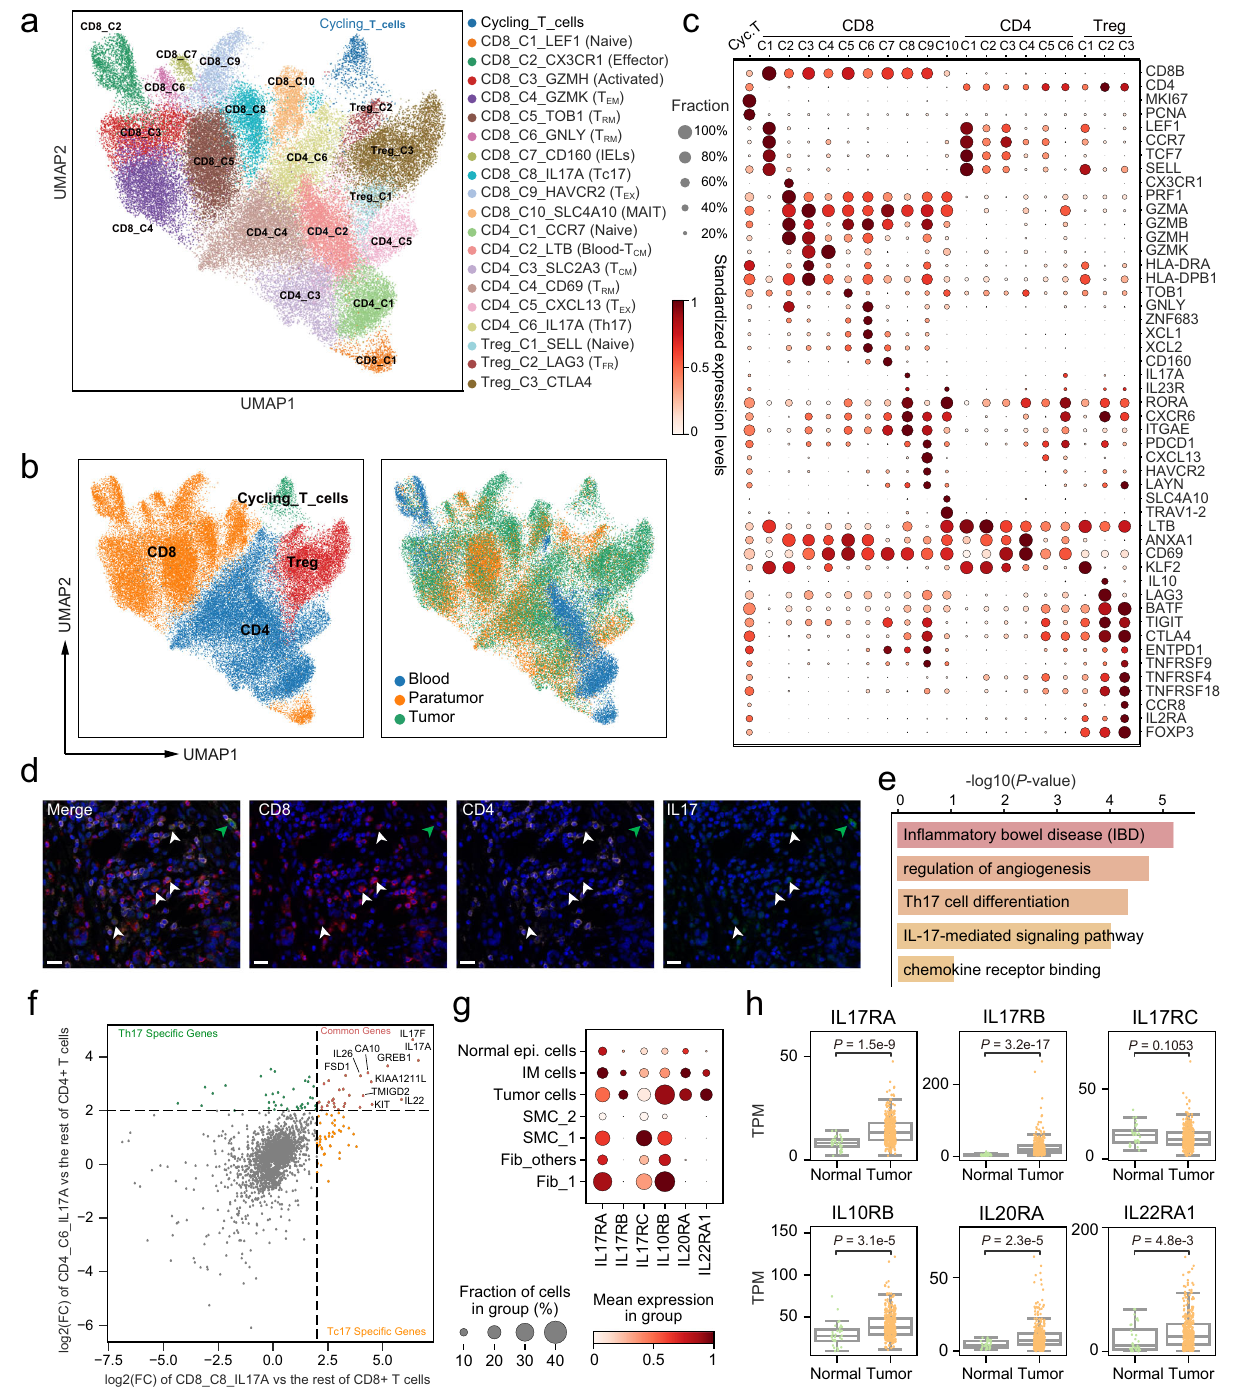
log2(FC) of CD8_C8_IL17A vs the rest of CD8+ T cells Fig. 5 | Dissection and clustering of T cells implicating multiple distinct func- calculated by the hypergeometric distribution. f Scatterplot showing the log 2 fold tionalstatesandgenemodulesinGCecosystem.a UMAPofTcellsthathadboth change of differentially expressed genes. CD8_C9_HAVCR2 versus other CD8 + T cells (X-axis); Treg_C3_CTLA4 versus other CD4 + T cells (Y-axis). Each dot repre- scRNA-seq dataand pairedTCR information. Clustersare labeled withinferred cell sents a gene, with color annotation inside. g Dot plots showing the expression of types. b DotplotsshowingmarkergenesacrossTcellsubsets.Dotsizeindicatesthe genes encoding the receptors for IL17A , IL17F ( IL17RA / IL17RC ), IL22 proportion ofexpressing cells, colored by standardized expression levels. c UMAP ( IL10RB / IL22RA1 ), and IL26 ( IL20RA / IL10RB ) in scRNA-seq dataset. h Box plots of T cells colored by cell type (left) and cellular tissue origin (right). d Multicolor showing the expression of genes encoding the receptors for IL17A , IL17F IHC staining with anti-CD4, anti-CD8, and anti-IL17A antibodies, exempli fi ed by ( IL17RA / IL17RC ), IL22 ( IL10RB / IL22RA1 ),and IL26 ( IL20RA / IL10RB )intumor ( n =375) patient GC988401 ( n =6).The white and green arrows indicate CD8 + IL17 + cellsand CD4 + IL17 + cells,respectively.Thescalebarrepresents20 μ m. e BarplotoftheKEGG and normal tissue ( n =32) of TCGA-STAD dataset, grouped by tissue origin (two- sided Wilcoxon rank-sum test). Source data are provided as a Source Data fi terms or pathways enriched for highly expressed genes in Tc17, the p -values were